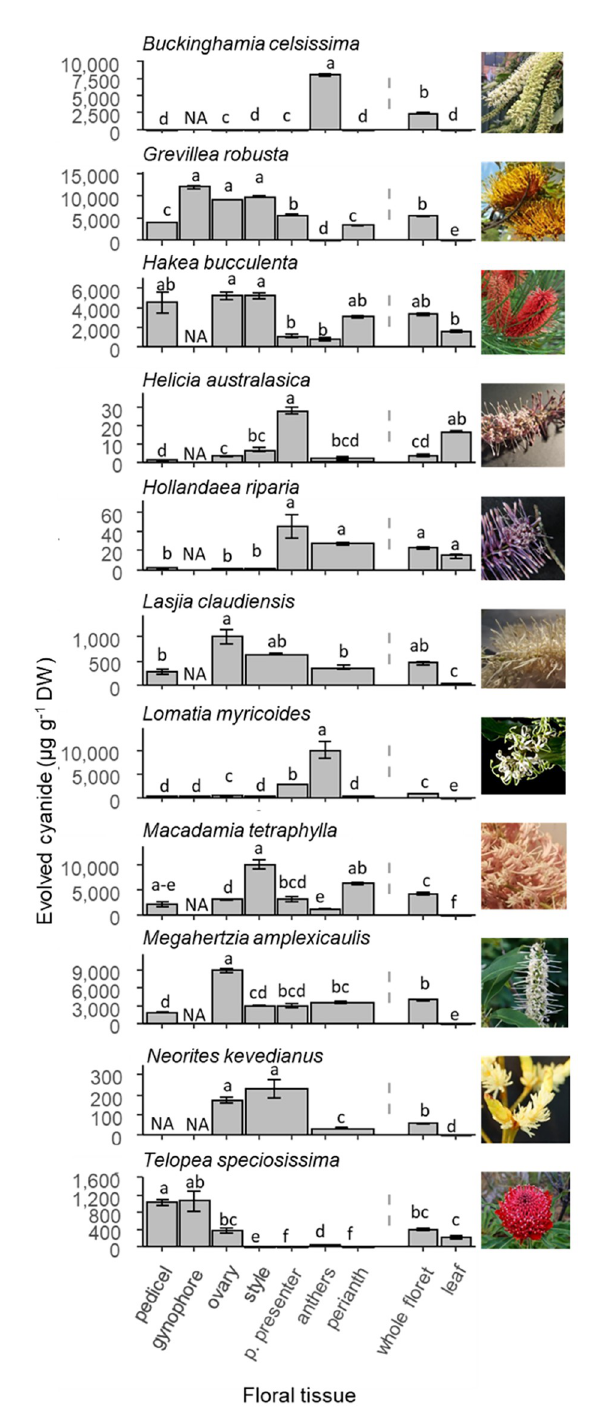
Fig 1. The content of cyanogenic glycosides measured as evolved cyanide ( μ g CN g -1 DW) in specific floral tissues, whole florets and leaves from eleven Proteaceae species (means ± SE, n = 3–5). Inflorescence morphology is also shown. Evolved cyanide content differed significantly between floral tissues in all species ( P � 0.0001). Letters (abc) indicate significant differences between floral tissues for the same species, using Tukey HSD family grouping test; means that do not share a letter are significantly different. Interspecific differences in whole flower CNglyc content are in S2 Table. Wide bars indicate the content of two adjacent tissues analysed together. NA–tissue absent for the species. L . myricoides data are from